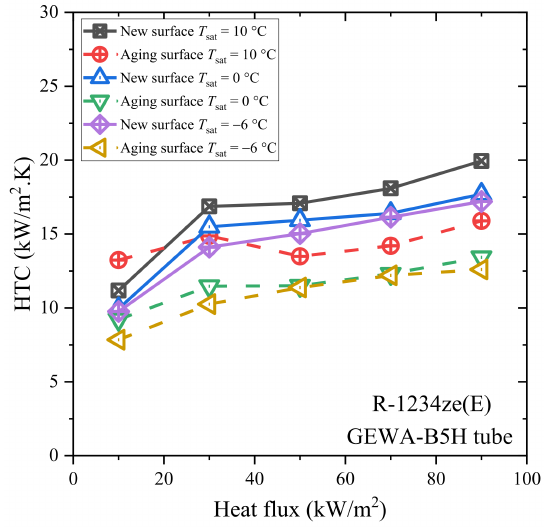
Figure 3. HTCs versus heat flux curves for new surface and aging surface.